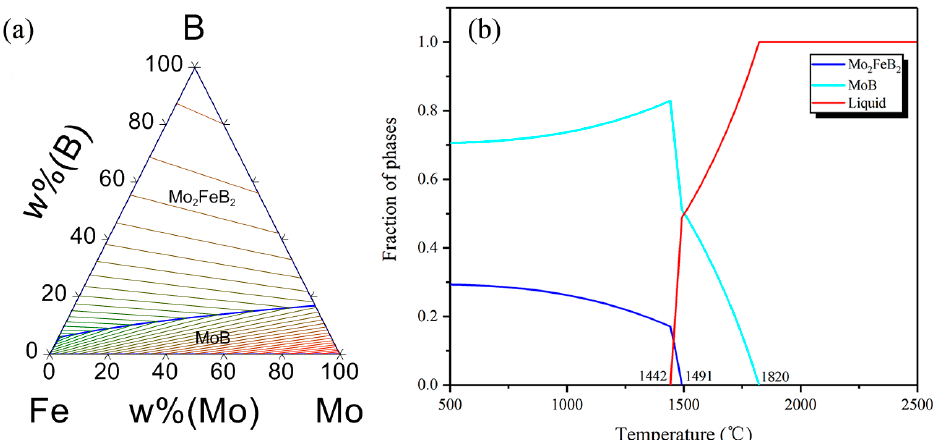
Figure 4. Calculated liquidus surface projection of Mo-Fe-B system and Molar fraction variation of each phase. ( a ) Liquidus surface projection; ( b ) molar fraction variation of each phase.